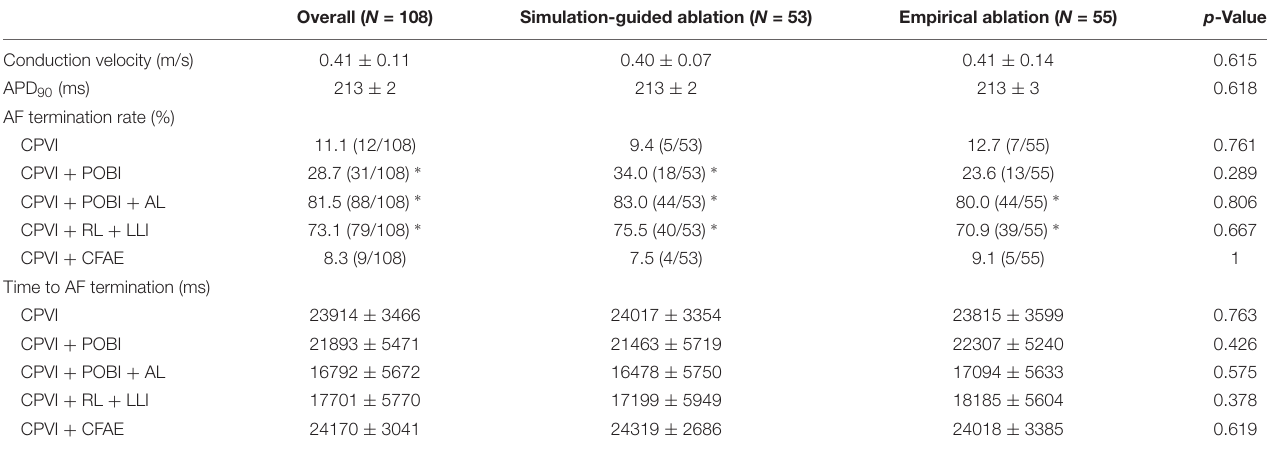
TABLE 2 | Virtual ablation outcomes. Overall ( N = 108) Simulation-guided ablation ( N = 53)